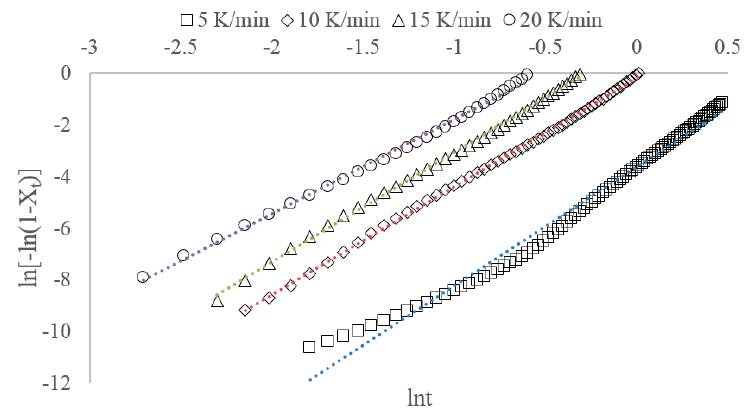
Figure 2. Plot of ln[ − ln(1 − X t )] against ln t of iPP/SDCNF10% composites according to Jeziorny model during crystallization at various cooling rates. Table 4. Crystallization parameters calculated from Jeziorny method.